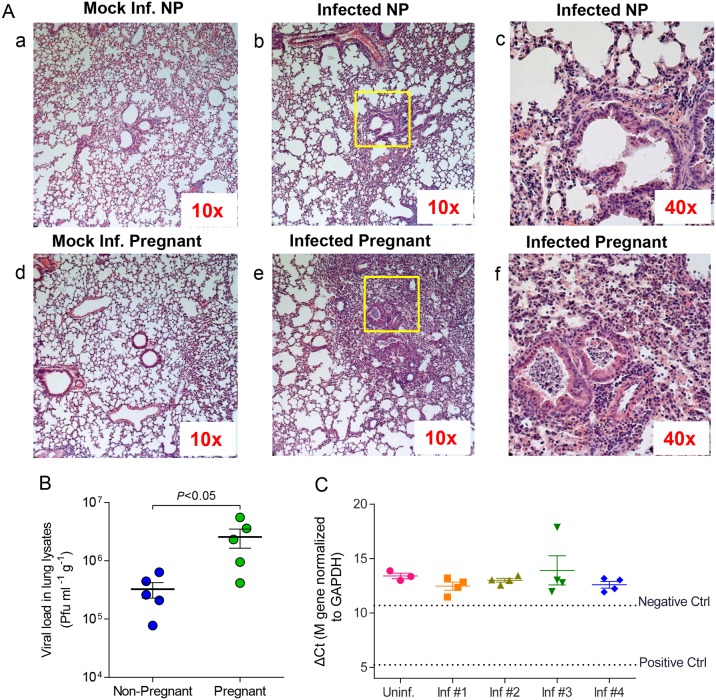
Pregnancy results in increased inflammation in the lungs and enhanced viral growth in lungs but not detected in placenta.A. Lungs from mock infected (a, d) and infected (b, c, e, f) pregnant and non-pregnant mice were stained with hematoxylin and eosin (H&E) 4 d.p.i. with mouse-adapted A/Brisbane/59/07 or mouse lung lysate at an equivalent dilution. (b, e) Lung sections at 10x magnification; (c, f) Inset boxes in (b, e) at 40x magnification represent lung structures. B. Viral load was quantified from lung lysates (N = 5 per group) 4 d.p.i via plaque assay in MDCK-derived cell lines and normalized per gram of tissue weight. C. Viral RNA was isolated from placental lysates (N = 4–5 per group) and probed for the presence of M gene RNA (A/Brisbane/59/07) via qPCR. Influenza-virus specific RNA was not detected below the negative control threshold (RNA isolated from mock-infected BALB/c lungs) or positive control threshold (RNA isolated from infected BALB/c lungs). Inf.: Infected mice; NP: Non-pregnant mice.